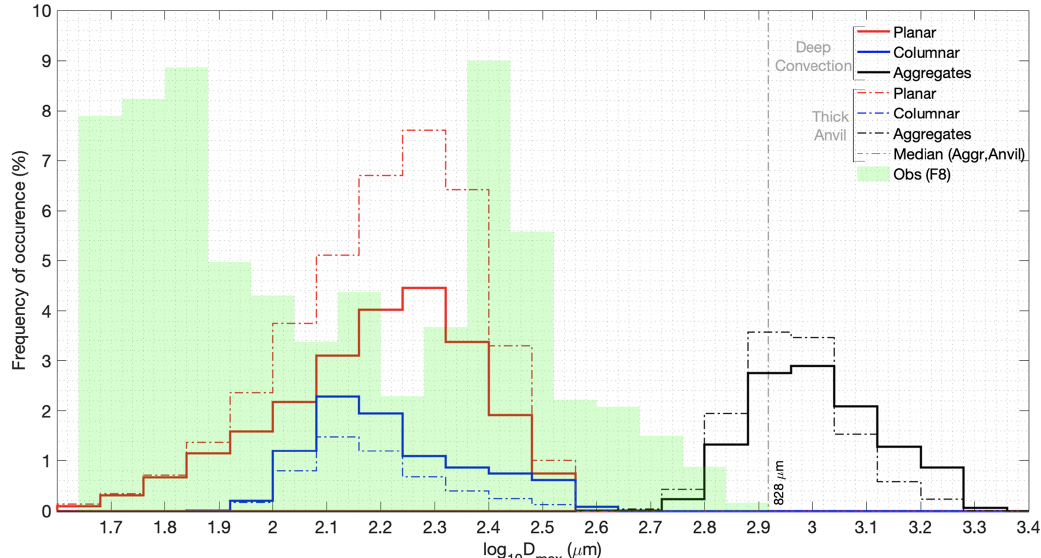
Figure 14. Distribution of ice particle maximum dimensions ( D max ) from observations (green shading) and the ISHMAEL scheme within the TTL in the deep-convection (solid line) and anvil (dashed–dotted line) regions for the following ice habits: planar (red), columnar (blue), and aggregate (black).